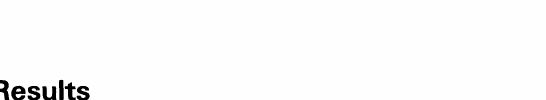
FIG. 2. Effect of Superdex 75 fractions on the inhibition of neu- trophil migration. The o-gal fraction obtained from 3.6 x 108 macrophages was applied to a Superdex 75 column. Fractions of 0.5 ml eluted in the volume range corresponding to proteins of 14-90 kDa were collected and assayed in vivo. The columns represent the neutrophil migration induced 4 h after carrageenin (300 pg, i.p.) in rats pretreated (30 min) with i.v. injections of the corresponding fraction (material obtained from 1.2 x 107 macrophages/0.2 ml). Controls received PBS or crude superna- tant. The chromatographic profile was determined at 230 nm. *p < 0.01 compared to PBS (ANOVA + Student’s